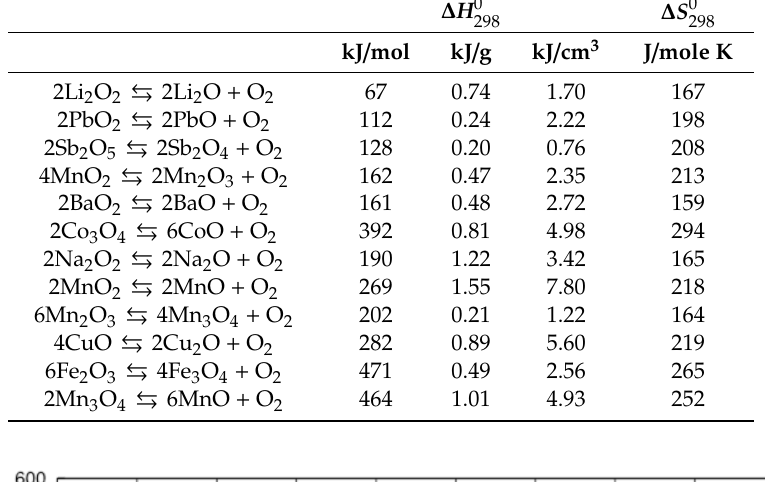
Table 1. Heat and entropy of reaction for the most relevant metal oxide systems from [30–35].